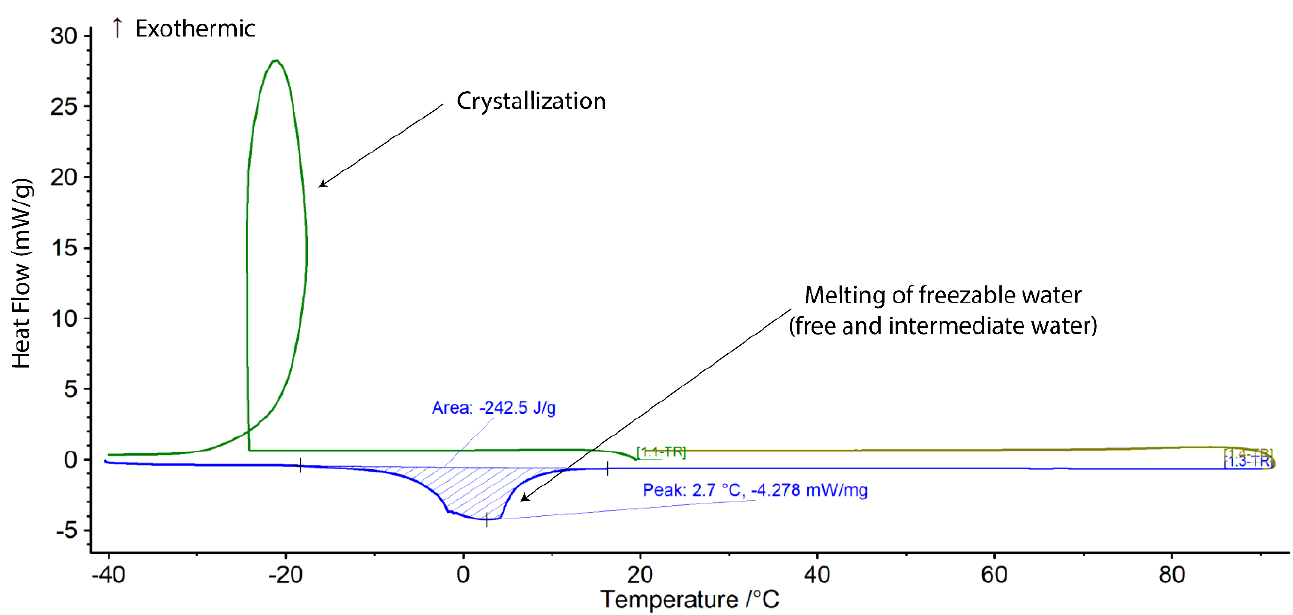
Figure 1. Differential scanning calorimetry (DSC) thermogram of 15% GelMA crosslinked in PBS and swelled in PBS.